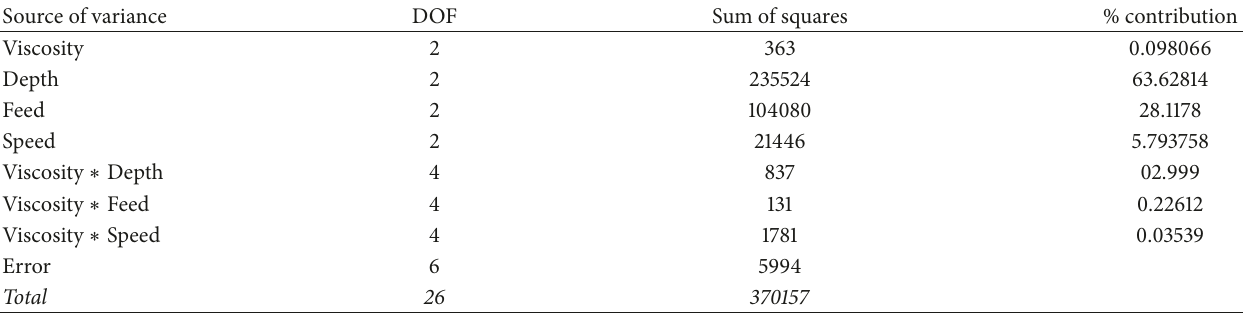
Table 5: ANOVA interfamily cutting force.